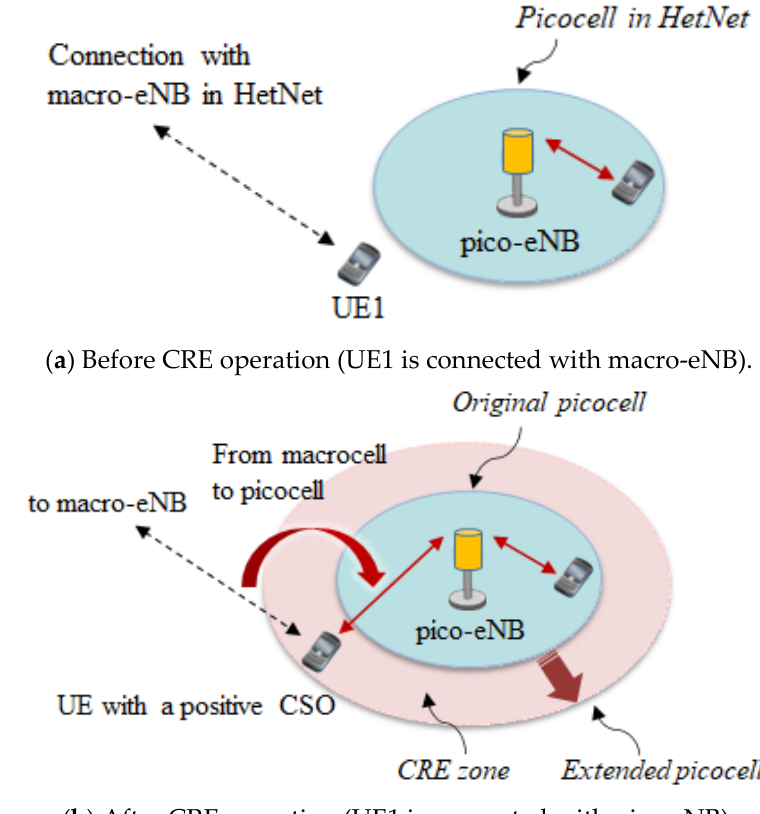
Figure 11. A CRE using a positive CSO in HetNet. In a normal case without CRE, UE1 outside the picocell is connected with a